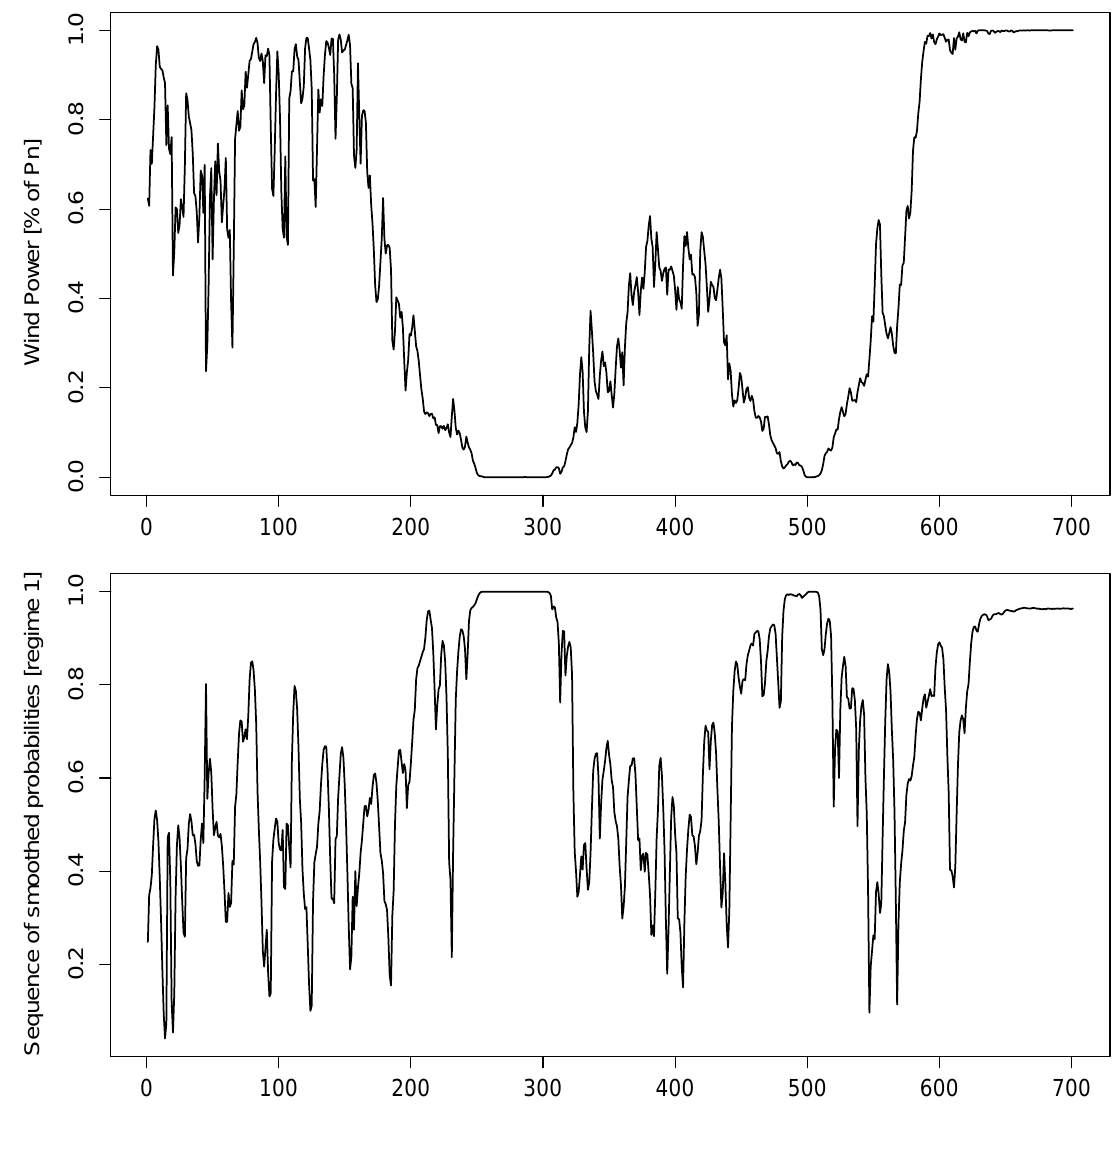
Figure 7. Time series of wind power and estimated sequence of smoothed probabilities of being in regime 1 ( i.e. , low volatility